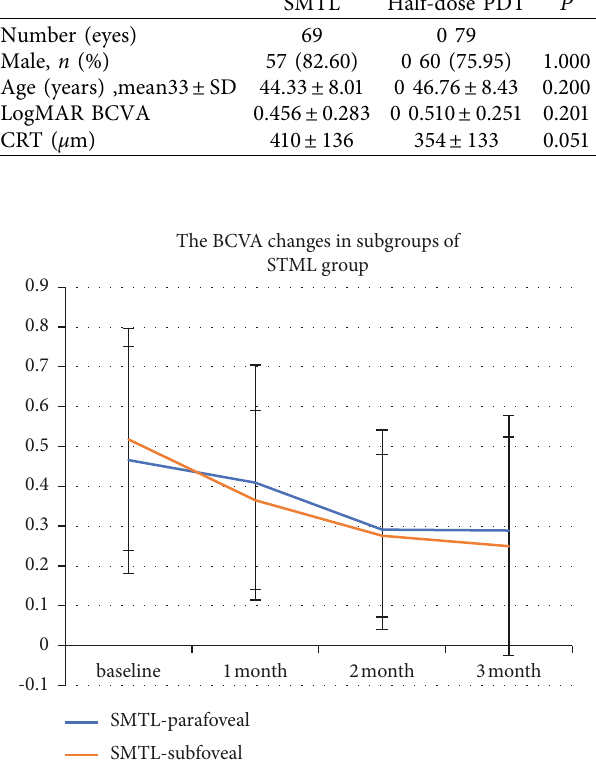
Figure 3: Best-corrected visual acuity (BCVA) changes in the parafoveal and subfoveal subgroups in the SMTL. The BCVA at the baseline and 1, 2, and 3 months during the follow-up period is shown in this figure. The parafoveal and subfoveal subgroups in the SMTL group analysis revealed that the treatment could improve visual outcomes. The change in BCVA in the SMTL-subfoveal group was defined with a red line chart, while the change in BCVA in the parafoveal group was defined with a blue line chart ( P 0 . 582; 0.605; 0.837; 0.674). (cid:31)